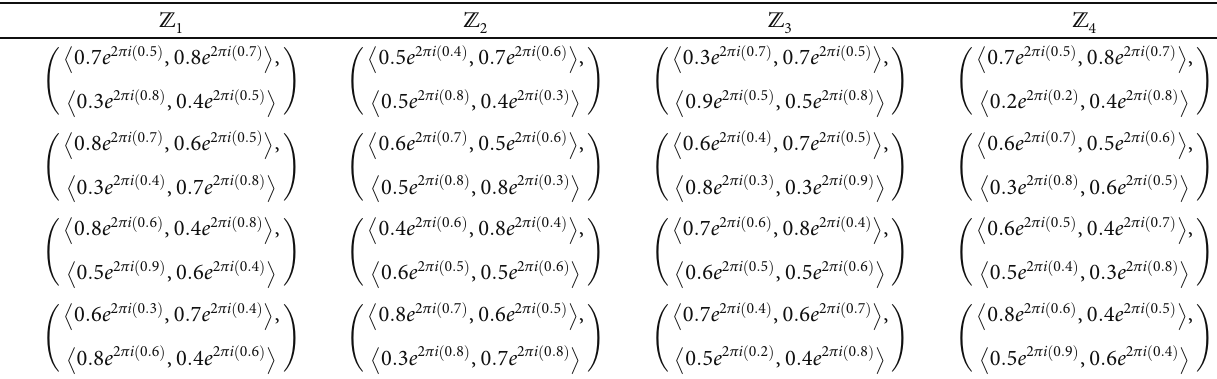
Table 2: Cq-ROFR evaluation information given by expert E 2 .